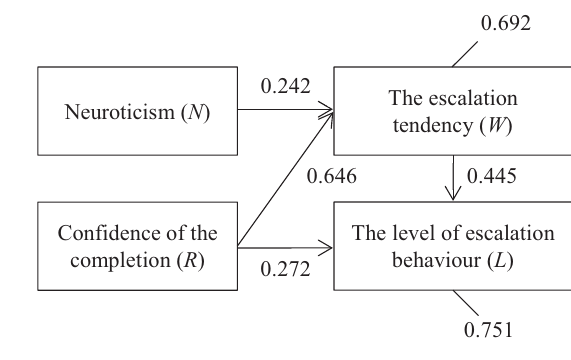
Figure 3. EOC model in Scenario II